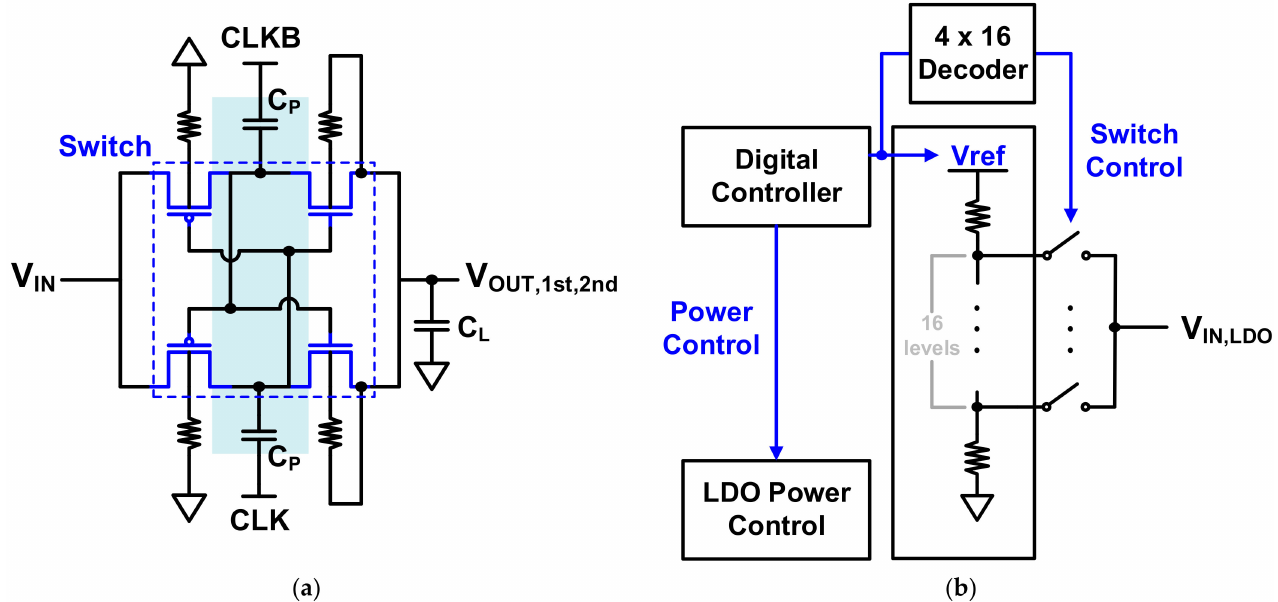
Figure 7. ( a ) NCP core (conventional doubler-based negative charge pump); ( b ) negative voltage generator digital control for